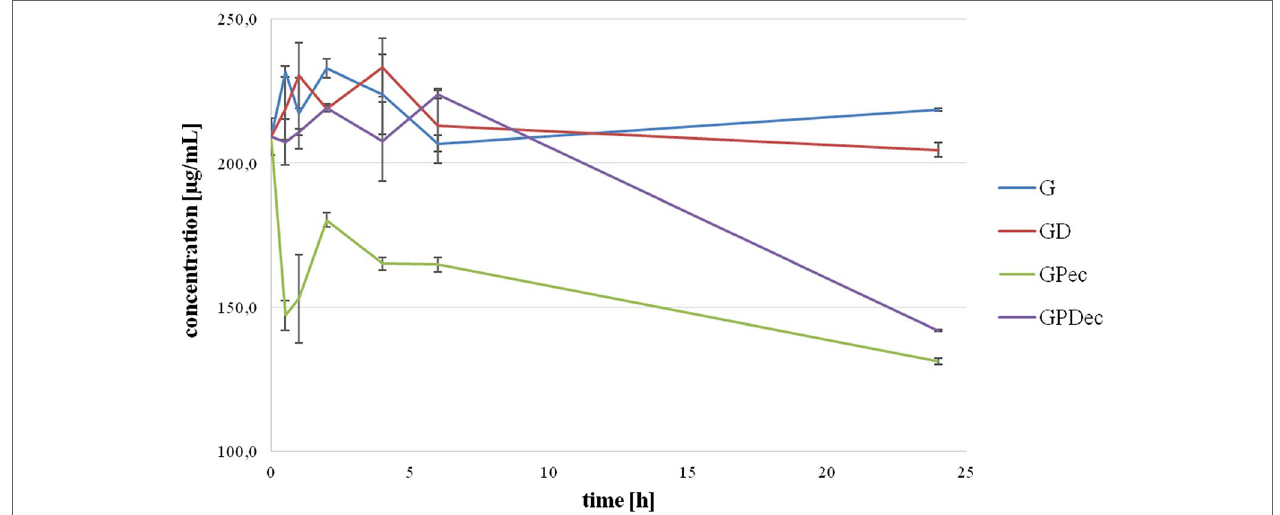
FIGURE 1 | Extracellular gliclazide concentration during incubation with probiotics, without (GPec) and in the presence of deoxycholic acid (GPDec), compared with their control groups (G) and (GD),